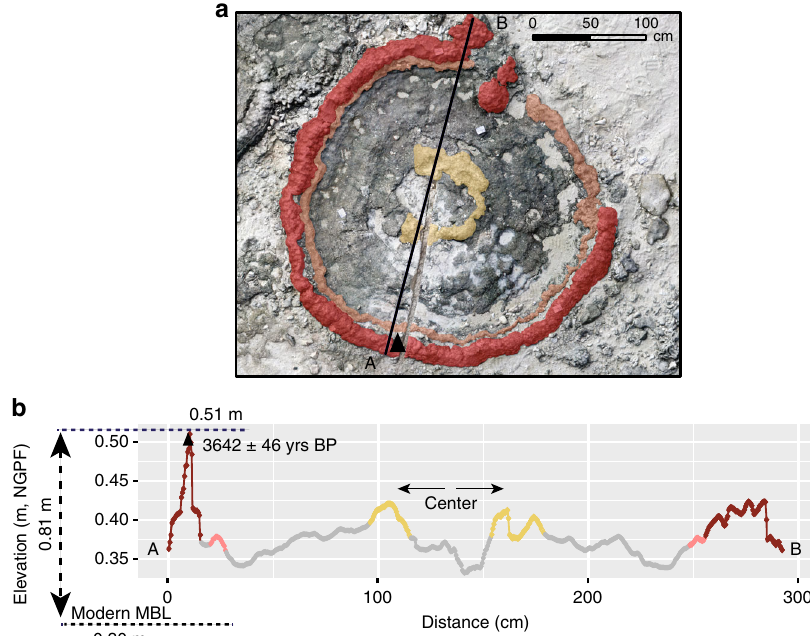
Fig. 6 High-frequency sea-level fl uctuations. Variations of the surface elevation of a microatoll from Maupiti indicate low-amplitude, high-frequency sea- level fl uctuations on the order of 20 cm. a Photogrammetry and b variations of the surface elevation of MAU-101. The central part of the microatoll and its outer margins are highlighted in yellow and red, respectively. The triangle indicates the position of the dated sample. The modern counterpart is located at − 0.30 cm and reveals a 0.81 m higher sea level at 3.64 ± 0.05 kyr BP. The arrows indicate the coral growth directions. Agisoft Photoscan Professional version 1.2 was used to produce the 3D